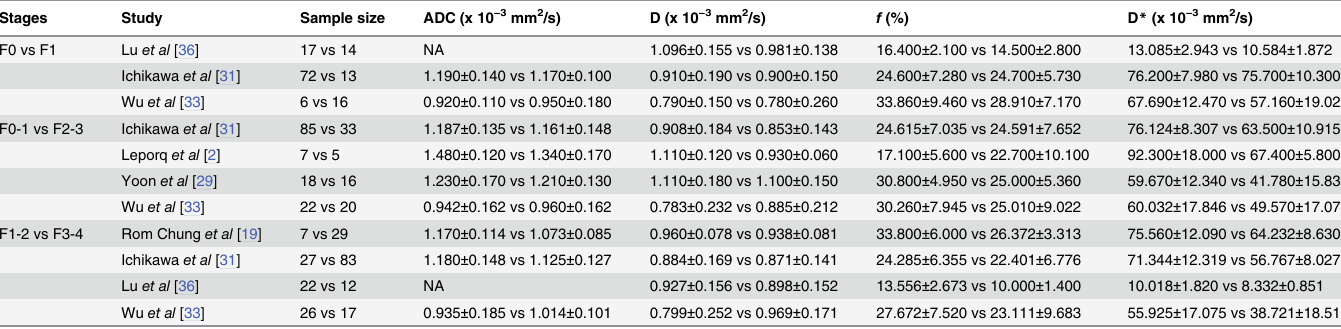
Table 2. Comparisions of different HF stages using IVIM-derived parameters and ADC value after pooled.